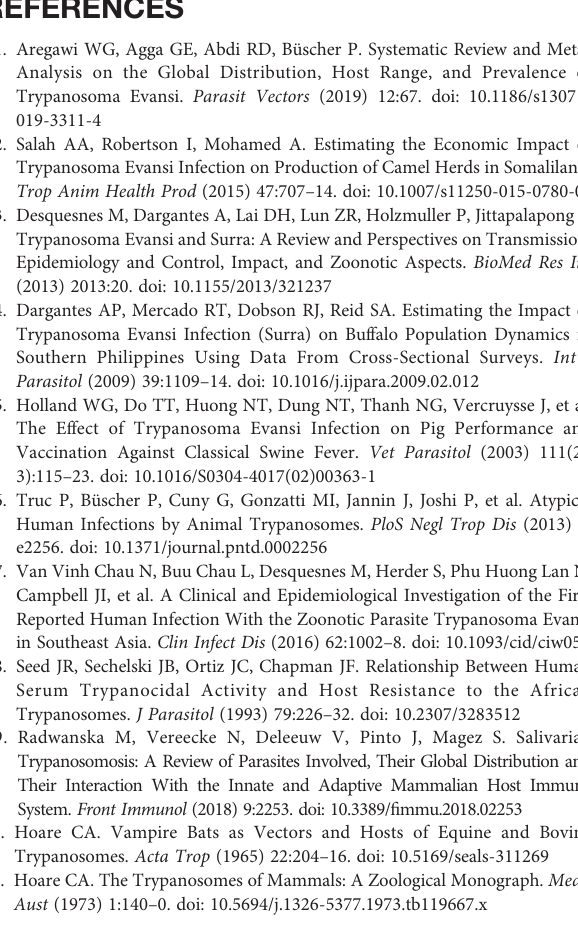
Supplementary Figure 1 | Gating strategy for Trypanosome CFSE replication assay. Supplementary Figure 2 | Calculated D10 for T. evansi RoTat 1.2 parasites.